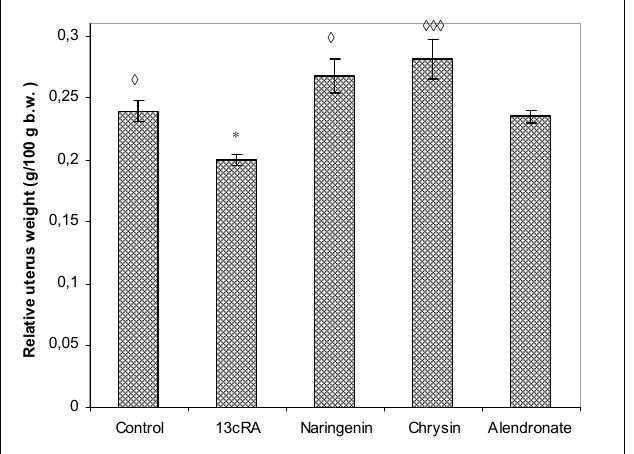
Figure 2. Effects of naringenin, chrysin, and alendronate on the relative uterine weight in rats with retinoic-acid-induced osteoporosis. Rats were administered ig with retinoic acid (13cRA) suspension (80 mg/kg) once daily for 14 days. After inducing osteoporosis with 13cRA, rats were administered ig with naringenin (100 mg/kg), chrysin (100 mg/kg), or alendronate (40 mg/kg), once daily for the next 14 days. Relative uterine weight was calculated as follows: relative uterine weight (g/100 g) = total uterine weight × 100/final body weight. Number of rats per group: 7. Data were analysed by the Kruskal–Wallis test. *—Statistically significant when compared with control (* p < 0.05). ◊ —Statistically significant when compared with 13cRA group ( ◊ p < 0.05; ◊◊◊ p < 0.001).